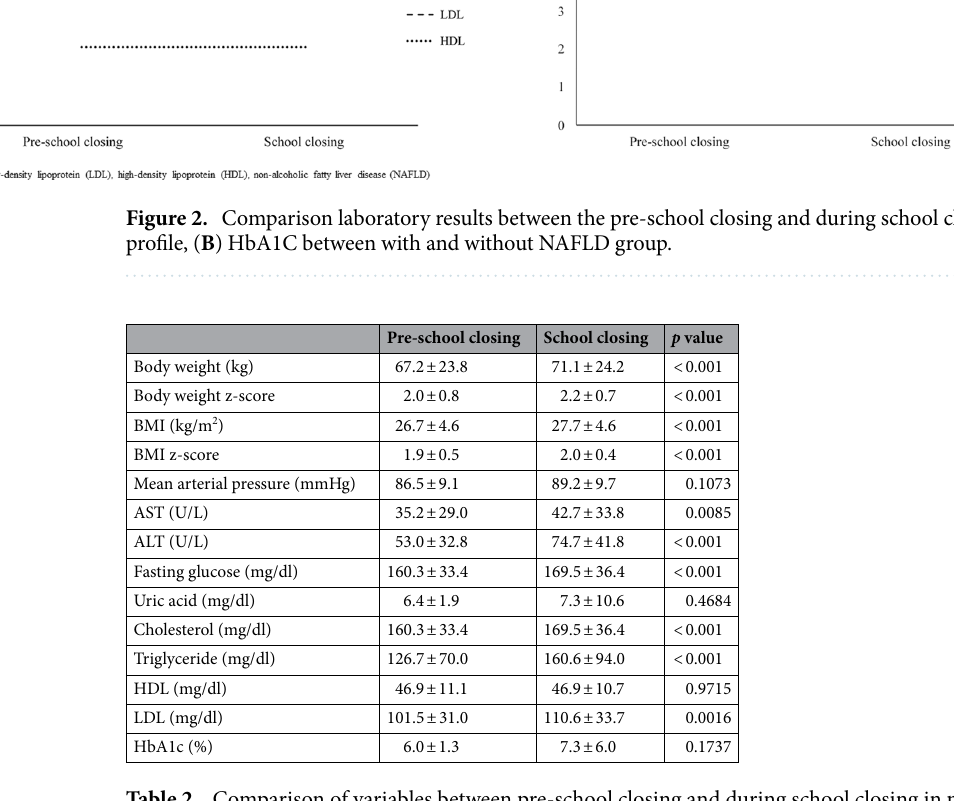
Table 2. Comparison of variables between pre-school closing and during school closing in patients with obesity. BMI body mass index, NAFLD non-alcoholic fatty liver disease, AST aspartate transferase, ALT alanine transferase, HDL high-density lipoprotein, LDL low-density lipoprotein, HbA1c hemoglobin